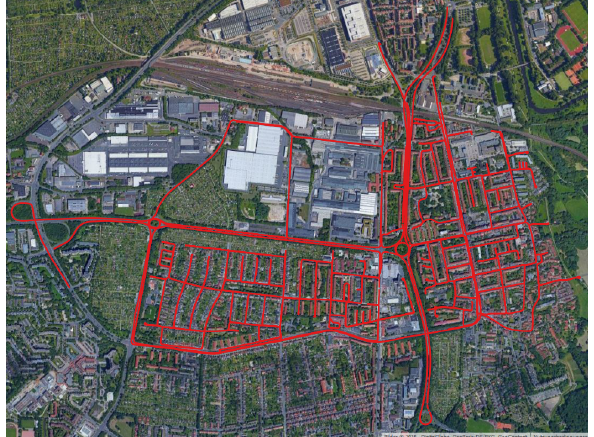
Figure 2. Trajectories of measurement campaign in the study area Hannover-Ricklingen (Basemap: Google Map)